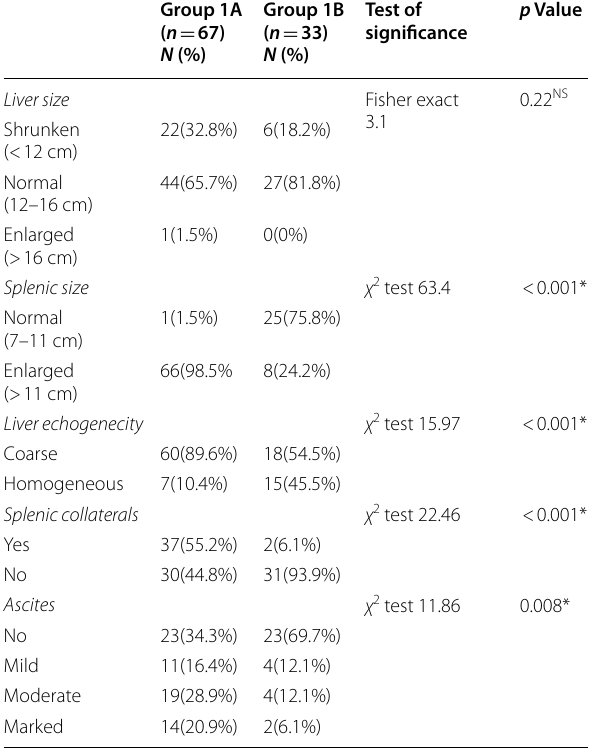
Table 3 Pelvi abdominal ultrasound findings of the studied